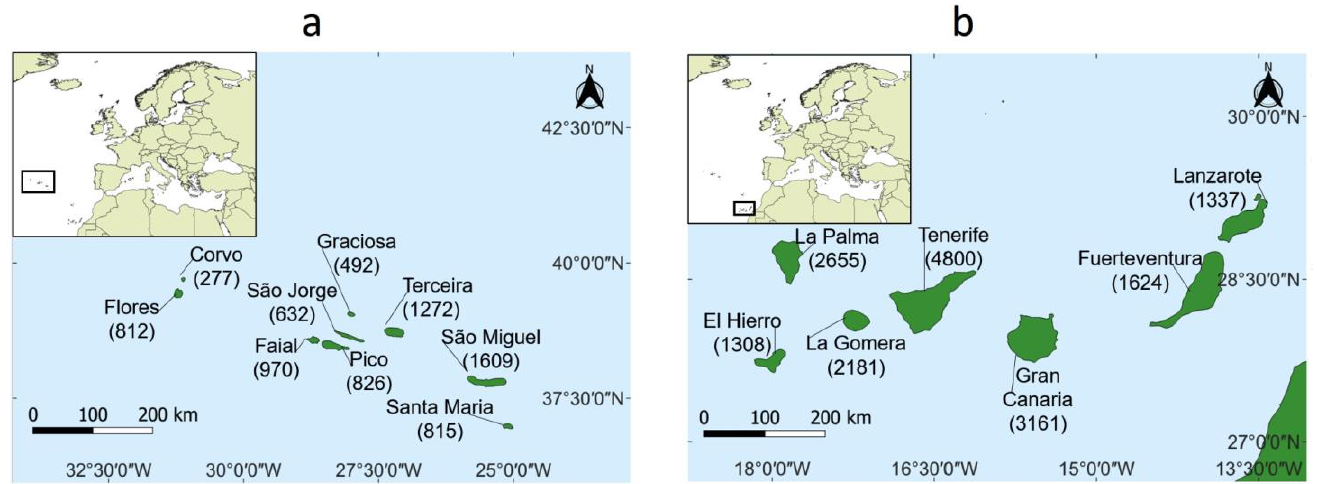
Figure 1. The archipelagos of the Azores ( a ) and of the Canary Islands ( b ); the total number of species in each island is shown in brackets.